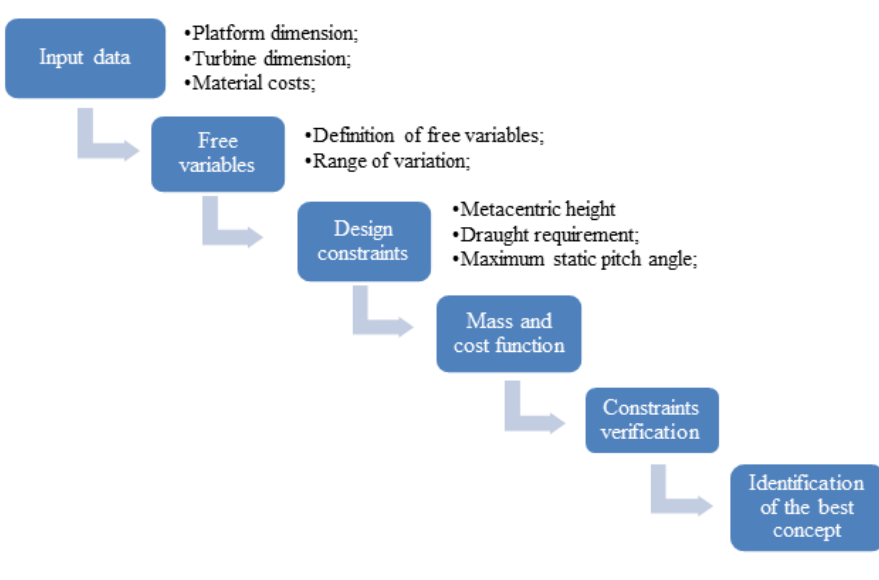
Figure 9. Genetic algorithm